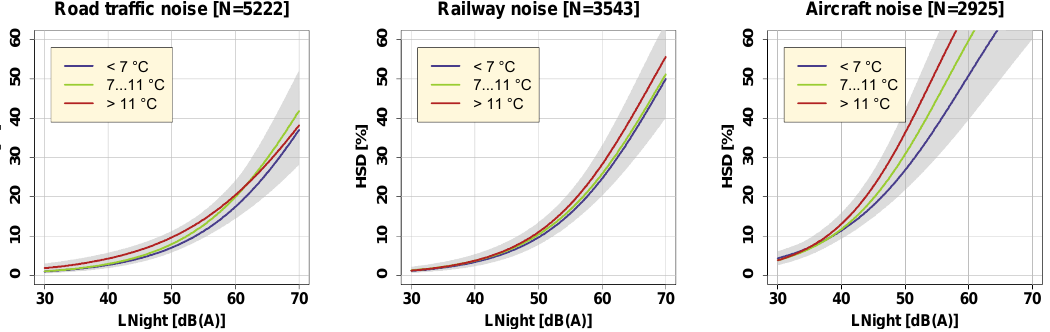
Figure 11. Exposure-response relationships obtained by the responses in the four seasonal waves. “Median date” in the legend refers to the median date of fill-out within the given survey wave. Curves are based on the adjusted model in the full sample with covariates centered on the mean and show (overlapping) 95% confidence intervals as shaded areas.